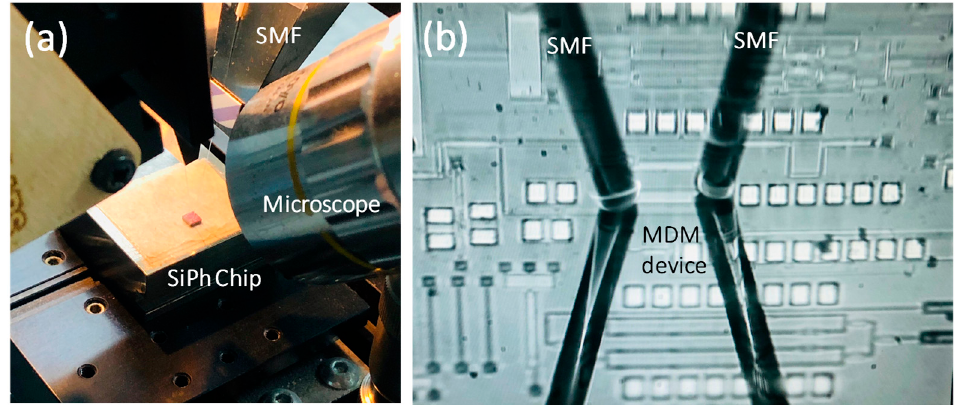
Figure 9. Experimental photos using two SMFs to couple optical signal in and out of the SiPh chip ( a ) before and ( b ) after zoom-in.